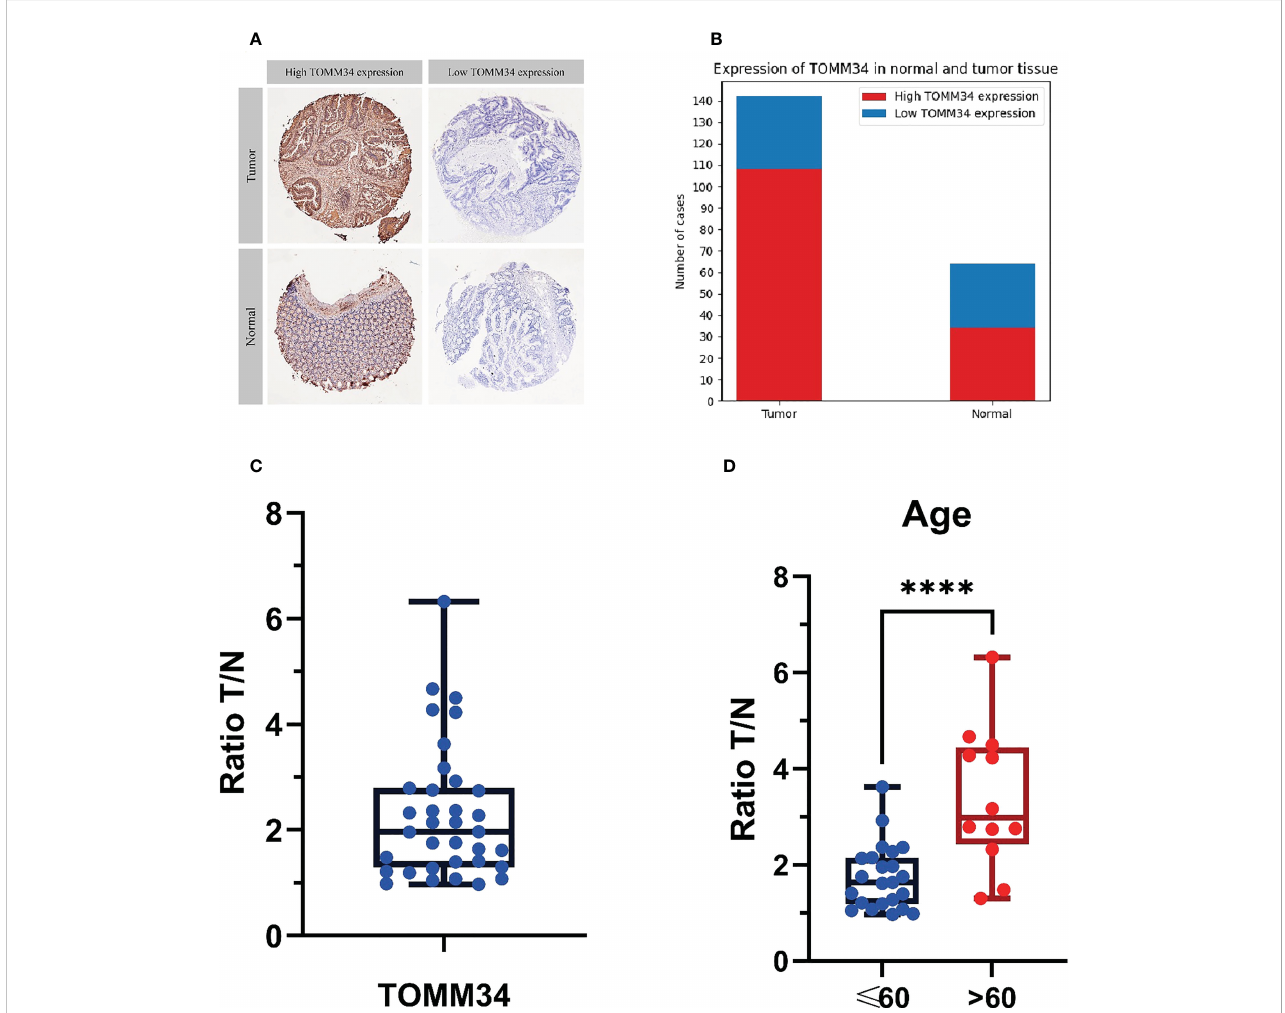
FIGURE 7 Immunohistochemical analysis of 206 samples and mass spectrometry analysis of tumor tissue and normal tissue in 35 patients. (A) The judgment standard for immunohistochemistry of TOMM34, in which cells stained in dark brown are de fi ned as high expression, and unstained or light yellow are de fi ned as low expression. (B) Qualitative analysis of the expression levels of TOMM34 in normal and tumor tissues by immunohistochemistry indicated that the expression levels of TOMM34 in tumor tissues were signi fi cantly higher than those in normal tissues. (C) Quantitative analysis of the expression of TOMM34 in tumor tissues and adjacent normal tissues of 35 colon cancer patients by mass spectrometry, showing that the expression of TOMM34 in tumor tissue was signi fi cantly higher than that in adjacent normal tissue. (D) The ratio tumor/normal (T/N) of patients under 60 years old and patients over 60 years old.